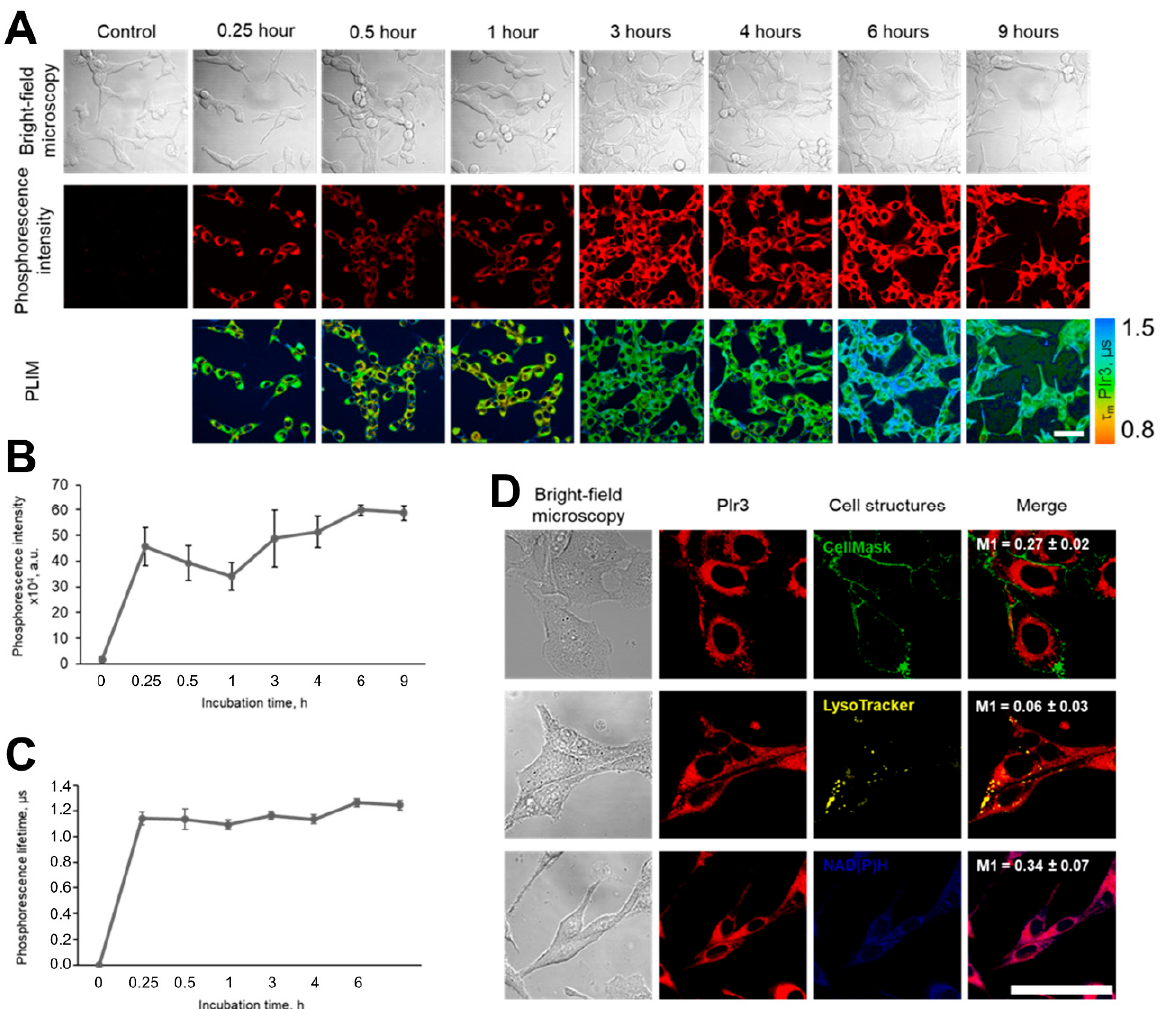
Figure 7. Cellular uptake and intracellular distribution of PIr3 in CT26 cells. ( A ) Bright-field, phosphorescence intensity and lifetime images obtained by laser scanning microscopy in the course of incubation with PIr3. ( B ) Phosphorescence intensity of PIr3 in cells. Mean ± SD, n = 70 cells. ( C ) Phosphorescence lifetime of PIr3 in cells. Mean ± SD, n = 50 cells; ( D ) Intracellular localization of PIr3. Phosphorescence of PIr3 is shown in red. Lysosomes were stained with LysoTracker Yellow HCK-123 (yellow), plasma membrane was stained with CellMask Green dye (green), and mitochondria were visualized by autofluorescence of NAD(P)H cofactor. Scale bar = 50 µ